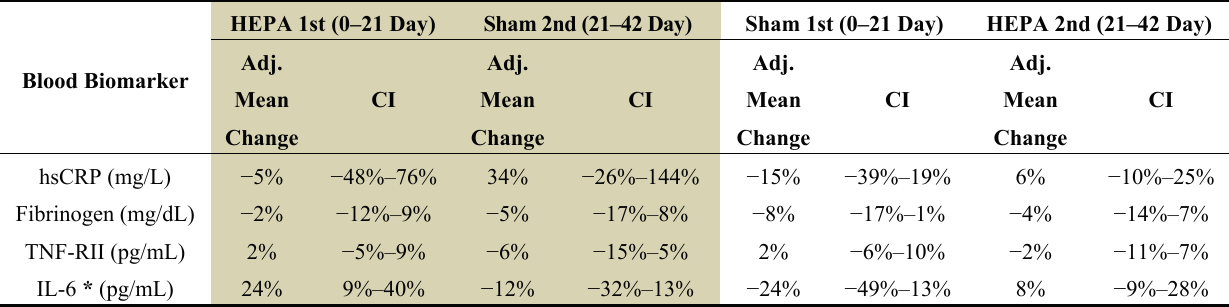
Table 5. Percent change from baseline and 95% confidence intervals (CI) for adjusted mean blood biomarker concentrations based on generalized estimation equation model. Means adjusted for baseline blood biomarker concentrations. All variables were analyzed in log scale and transformed prior to reporting.